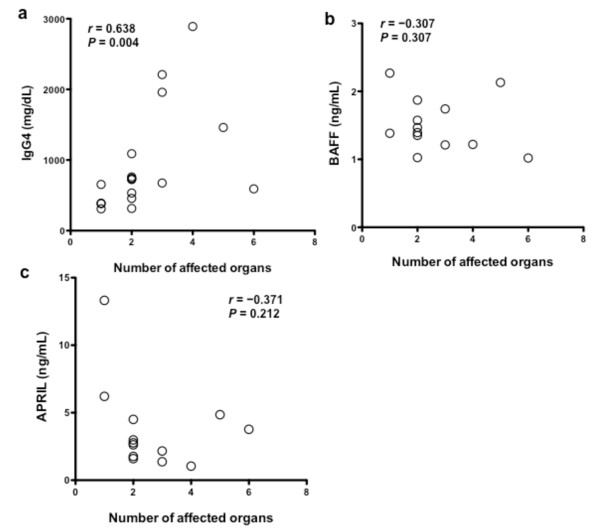
Correlation between organ involvement and serum IgG4, BAFF, or APRIL in patients with IgG4-RD. Correlation between the number of affected organs and IgG4 (a), BAFF (b), and APRIL (c) in patients with IgG4-RD.